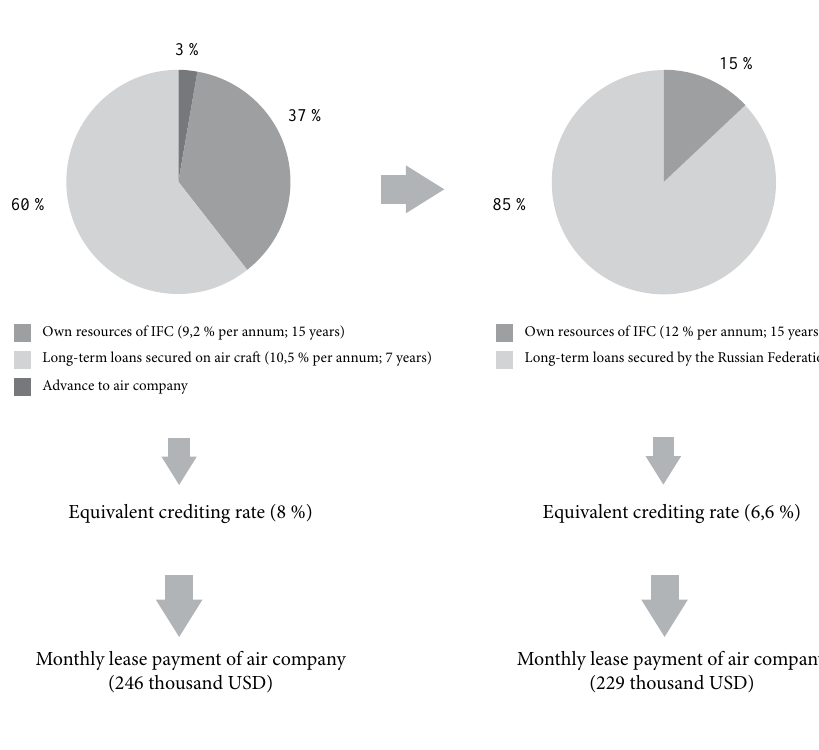
Fig. 3. Events to reduce cost of financing aircraft (Estimate for aircraft TY-204 of value 25 million USD net of VAT)(Aralov